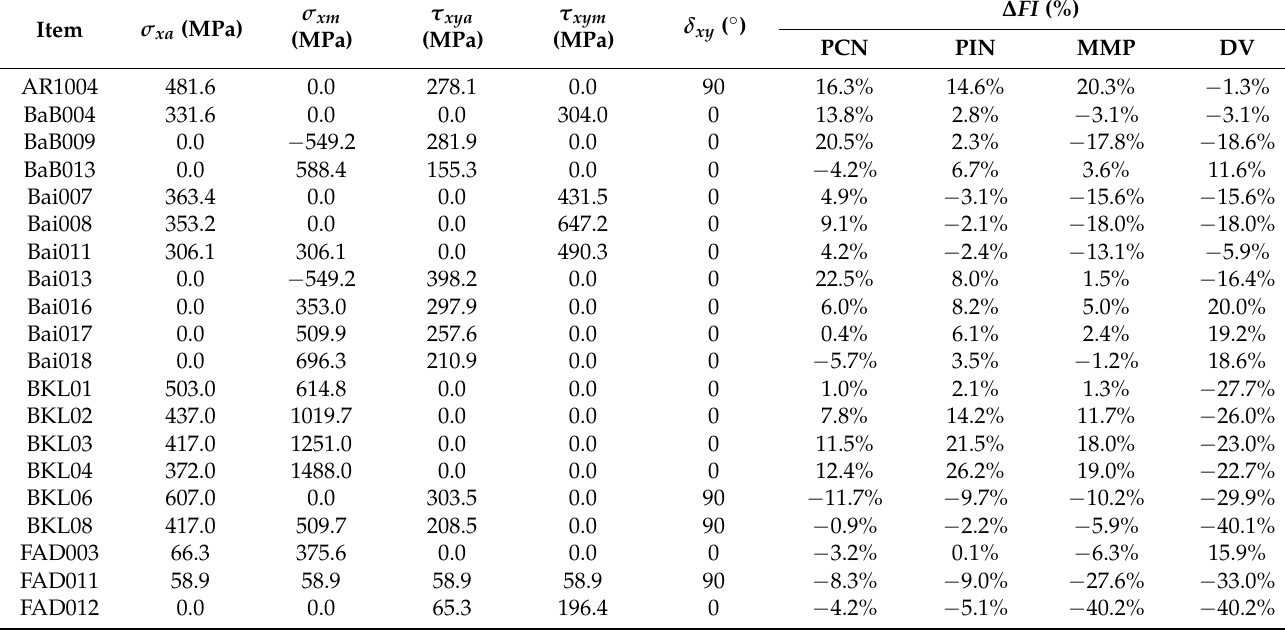
Table 4. Tension–torsion load cases in the AMSD25 data set and the response of reference multiaxial fatigue strength criteria to